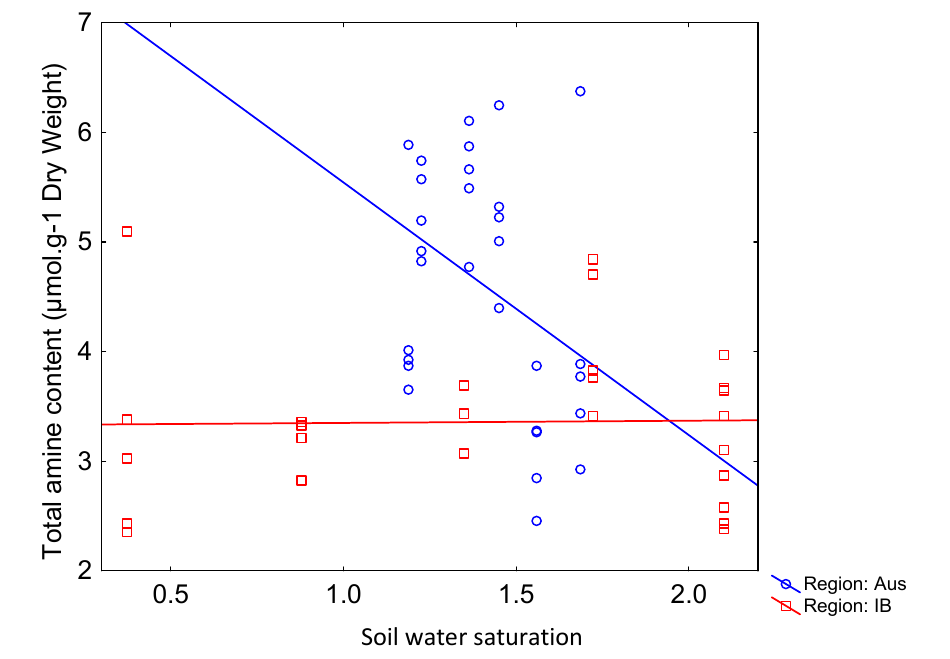
Figure 2. Illustration of region-dependent relationships of total amines to soil water saturation for R. pseudotrullifolius .